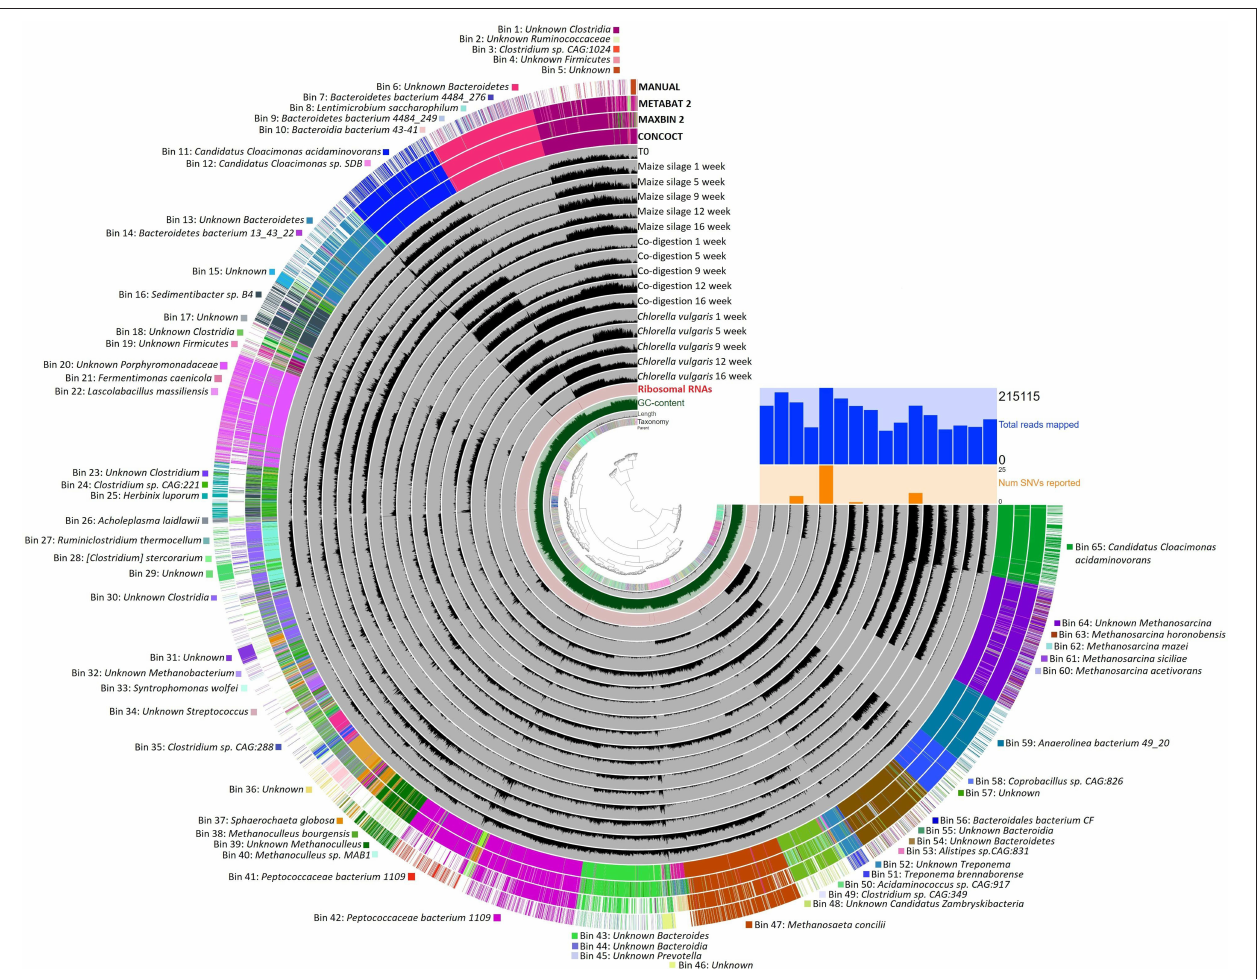
FIGURE 4 | Anvi’o interactive display of automated binning based manual assembly results. The dendogram in the center display the hierarchical clustering of contigs based on its sequence compositions. The layers from inside out are: (1) The parent layer that marks the splits originated from the same contigs with gray bars (split size 20,000 bps, e.g., Bin 2). (2) The Kaiju taxonomic layer shows the taxonomy for each open reading frame detected in a given split. (3) The length layer, shows the actual length of a given split. (4) GC-content layer. (5) Ribosomal RNA layer. (6) Gray layers represent a sample and each black bar is the coverage of a given split in a given sample. Orange bars represent SNVs detected, and blue bars shows the number of reads mapped in samples. CONCOCT, MAXBIN 2, METABAT 2 shows the automated binning and MANUAL layer the automated based manual binning results. Each bins and the corresponding taxa are listed around the